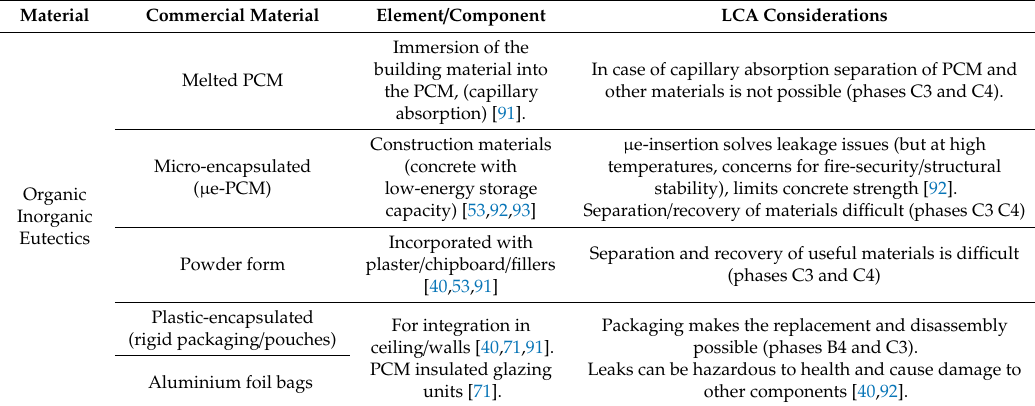
Table 7. Qualitative LCA considerations on tPCM components.